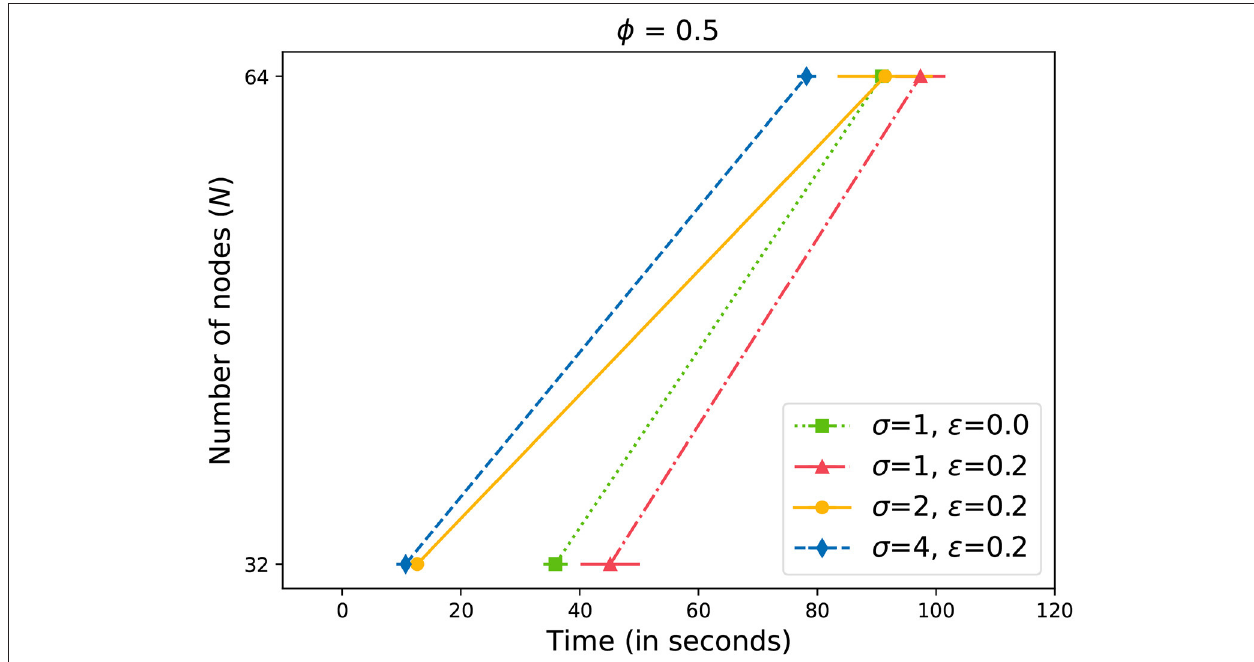
FIGURE 8 | Time to gossip a message with 20% failed nodes.